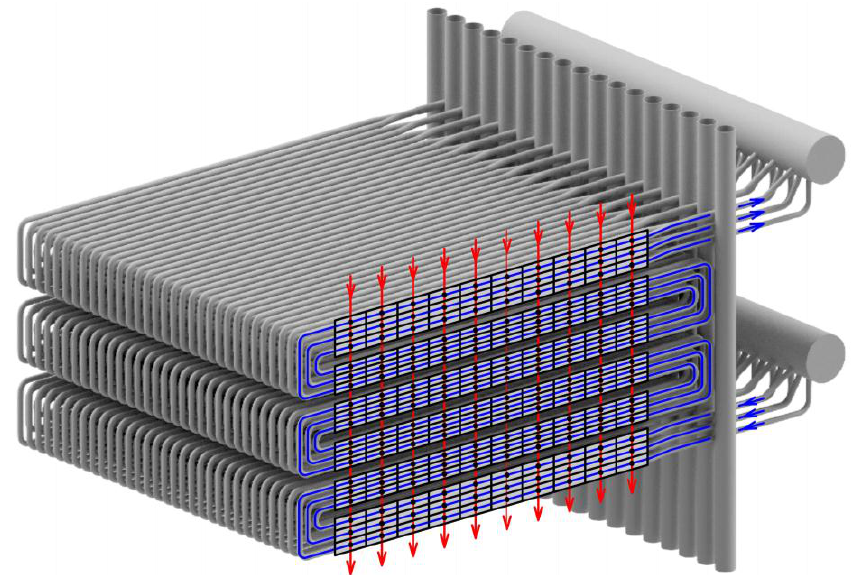
Figure 8. The 2D method applied to a model of the tubular steam superheater. Hot fluid (flue gas) is shown in red, cold streams (steam) are outlined as blue lines.